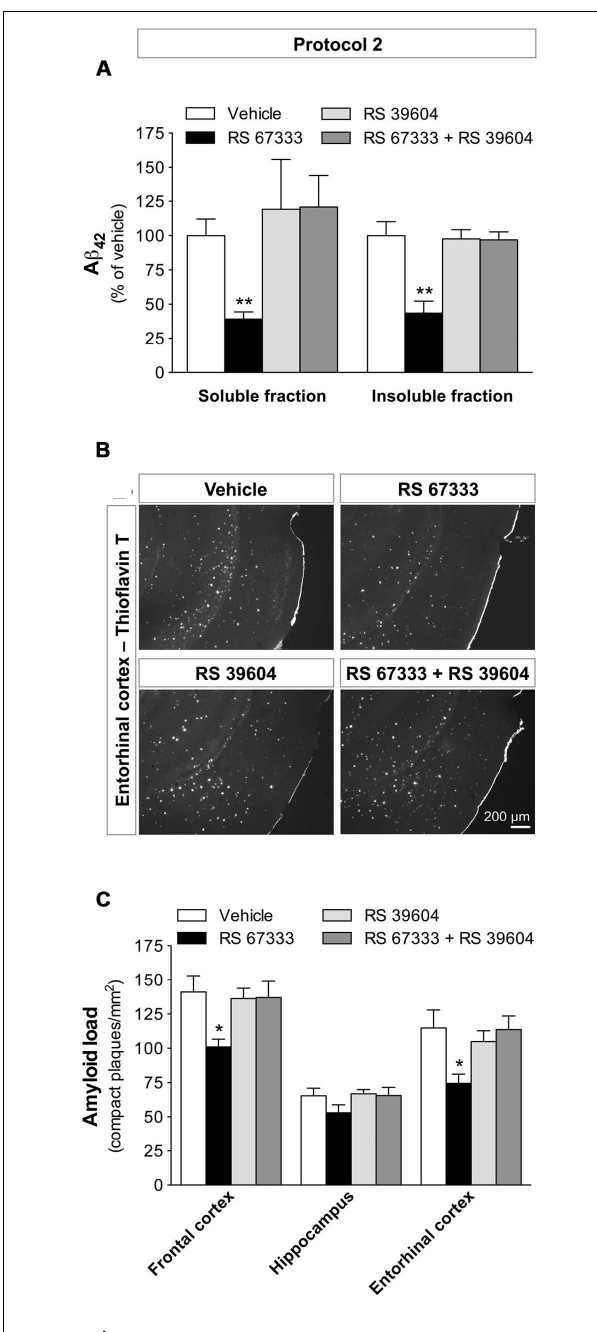
FIGURE 4 | RS 67333-induced reduction of amyloid pathology is prevented by pre-administration of the 5-HT 4 receptor antagonist RS 39604. Two-month-old 5XFAD females were treated with RS 67333 according to protocol 2 (1 mg/kg, twice a week, for 2 months) with or without pre-administration (15 min before) of the 5-HT 4 receptor antagonist RS 39604. (A) Quantification of A β 42 load in the brain insoluble and soluble fractions.The mean concentration (nanogram per milligram total protein ± SEM, n = 4/group) of A β 42 in the soluble and insoluble fractions from the vehicle-treated group was 0.77 ± 0.10 and 2079.0 ± 203.8, respectively. (B) . Representative images of thioflavinT staining in the entorhinal cortex (mosaics, 10 × objective). (C) Quantification of plaque number. Data are the mean ± SEM. ∗ p < 0.05, ∗∗ p < 0.01 compared with vehicle (unpaired Student’s t